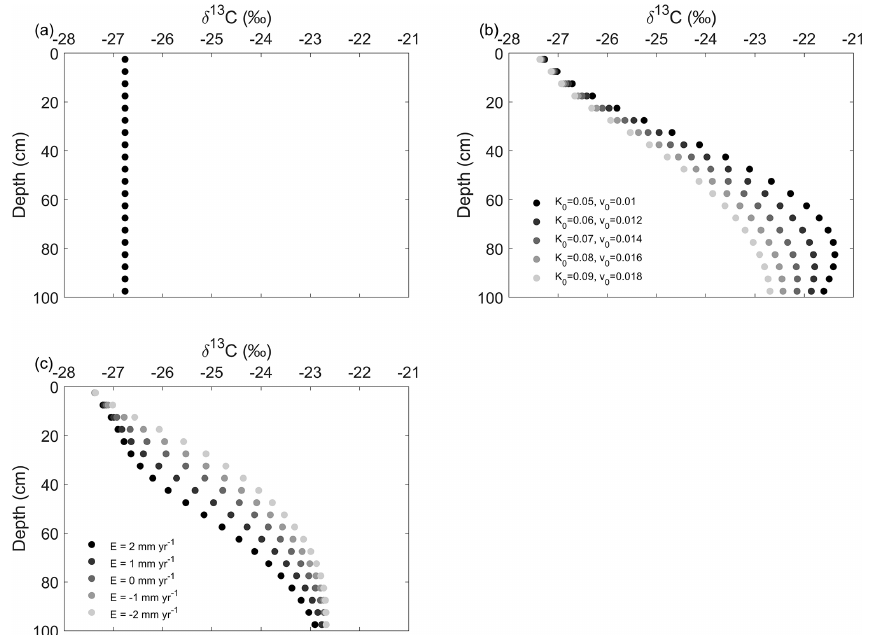
Figure 4. The simulated δ 13 C profiles in (a) Scenario 1, (b) Scenario 2 and (c) Scenario 3. See Sect. 2.2.7 and Table 2 for descriptions of the scenarios. In (b) , K 0 (myr − 1 ) is the diffusion coefficient at the topsoil layer and v 0 (myr − 1 ) is the advection term at the topsoil layer (Eq. 18). In (c) , E indicates the soil redistribution rates, with negative values indicating erosion and positive values indicating deposition. K 0 and v 0 were set to be 0.09 and 0.018myr − 1 , respectively. In (b) and (c) , both K d and v d (depth attenuation of diffusion and advection) were set to be 0.01m − 1 .